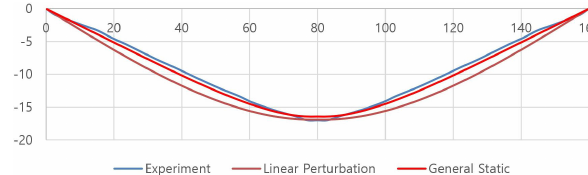
Figure 19: Comparison of bending deformation values in laminate